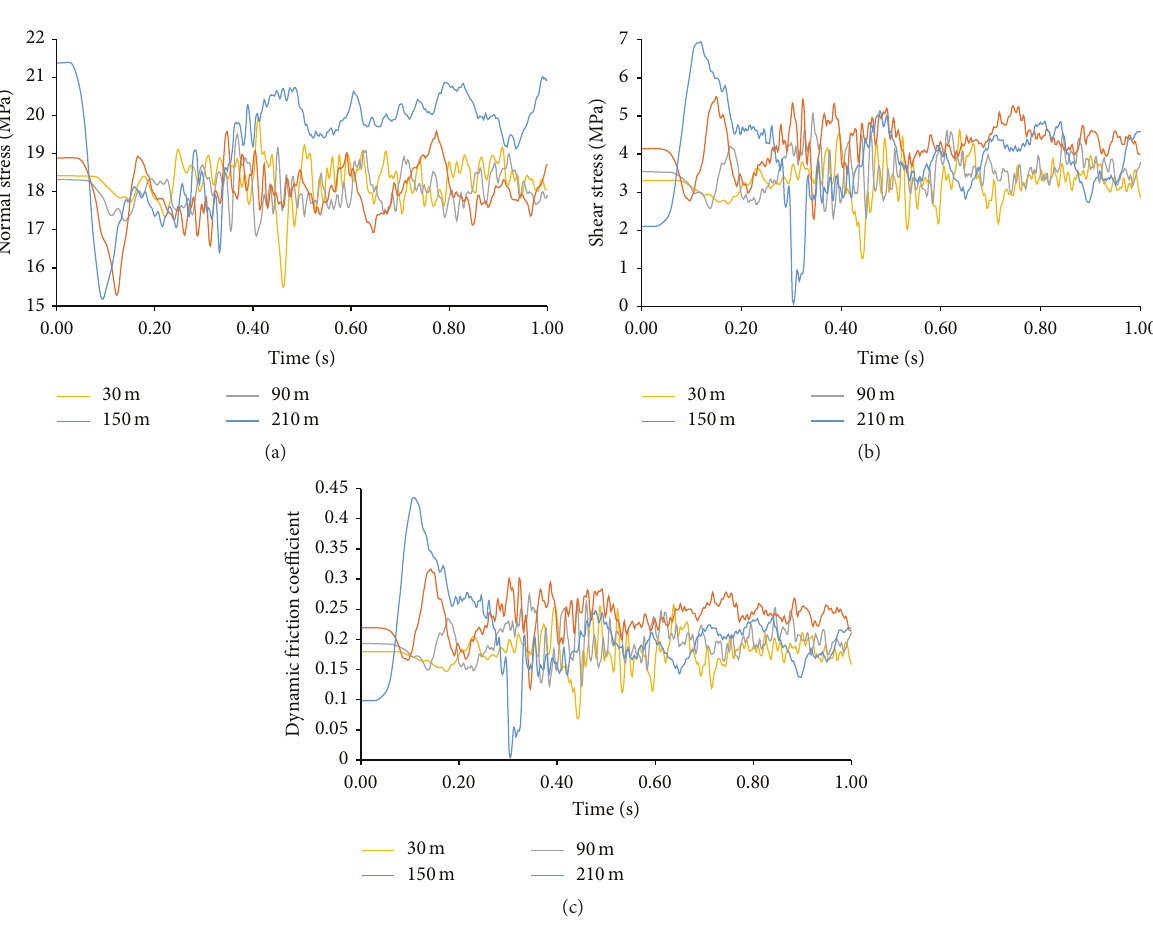
Figure 4: Stress evolution and dynamic friction coefficient along the fault at observation point ( 𝑝 𝑑𝑚 = 30 MPa, depth = 500 m): (a) normal stress; (b) shear stress; and (c) dynamic friction coefficient. Note that values in the boxes represent the length of panel